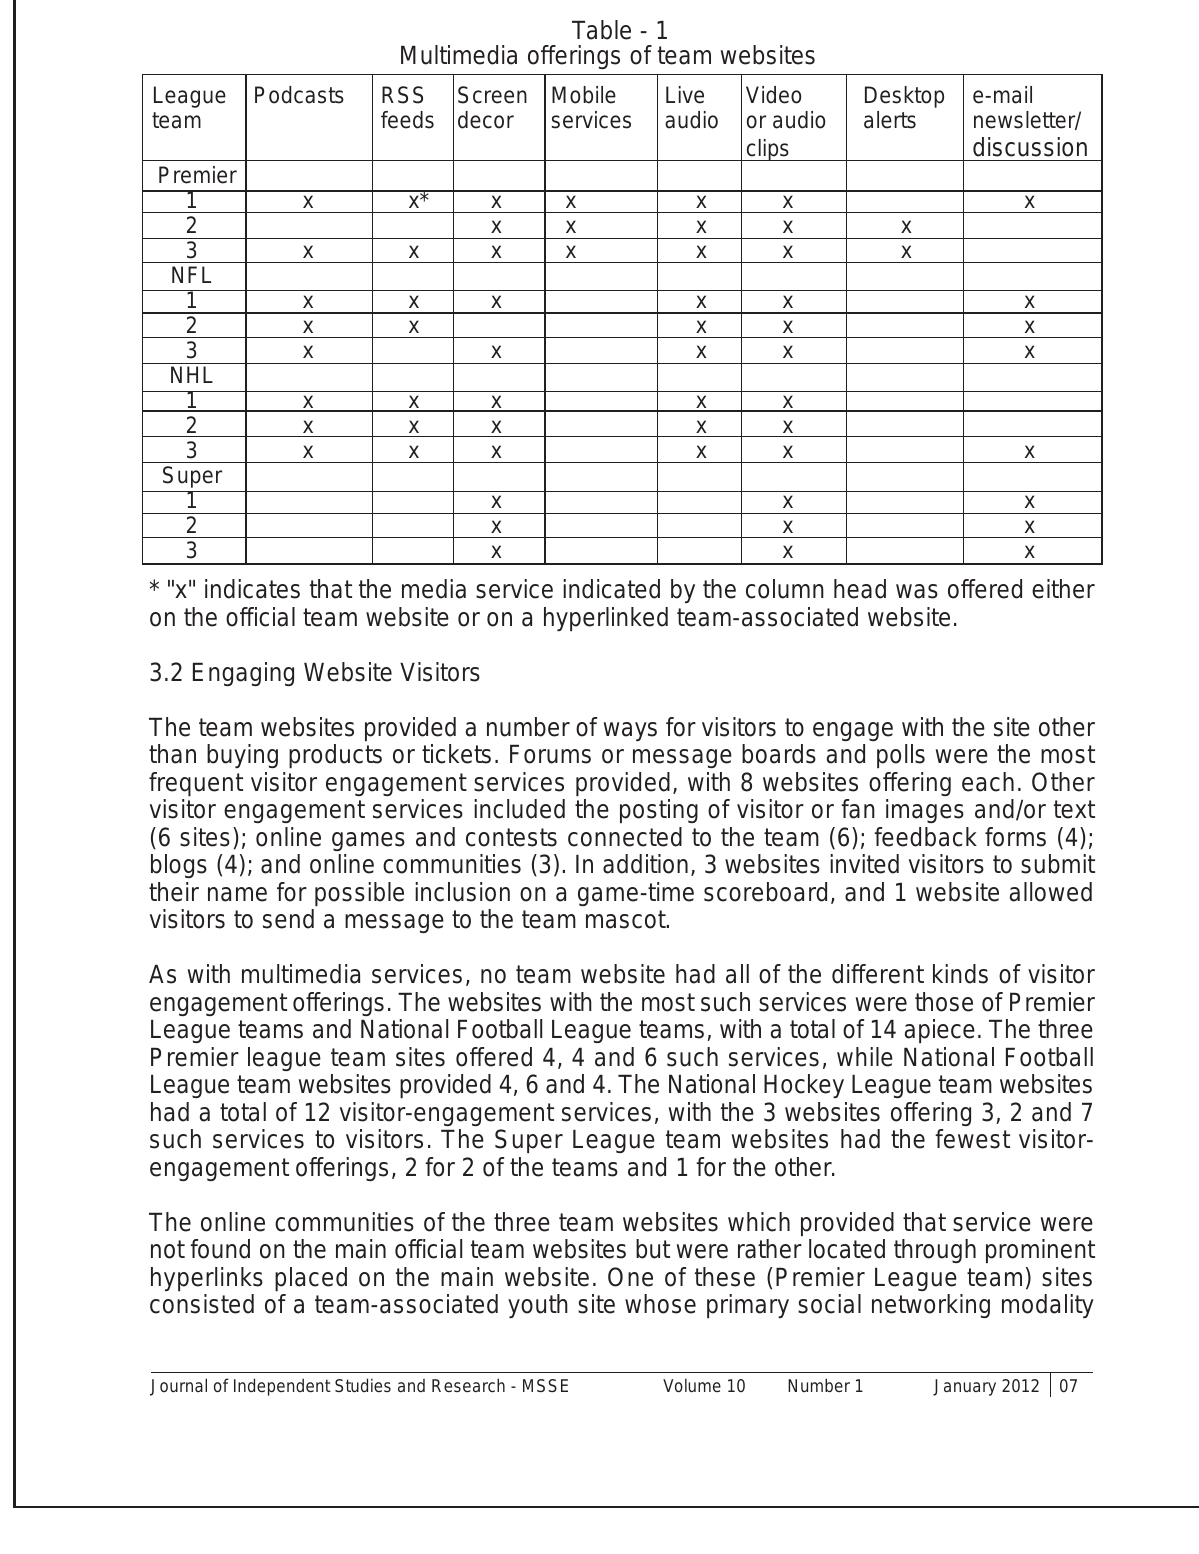
Table 1. provides a summary of the media services offered through the websitesinvestigated. Table - 1 Multimedia offerings of team